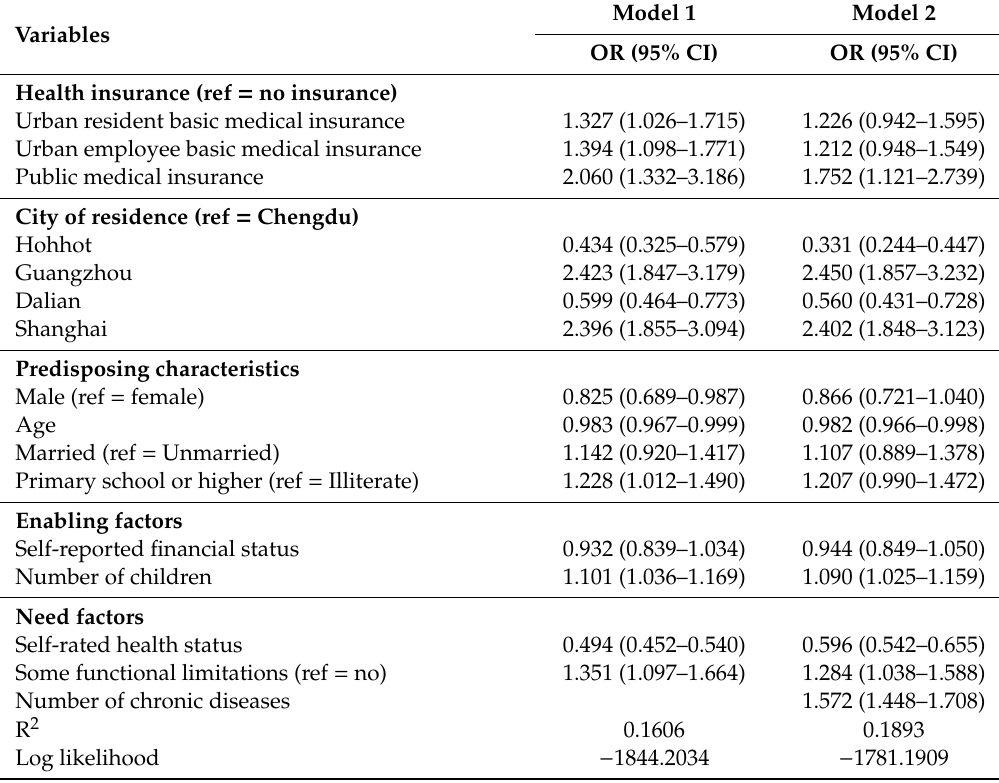
Table 3. Logistic regression models for factors associated with outpatient